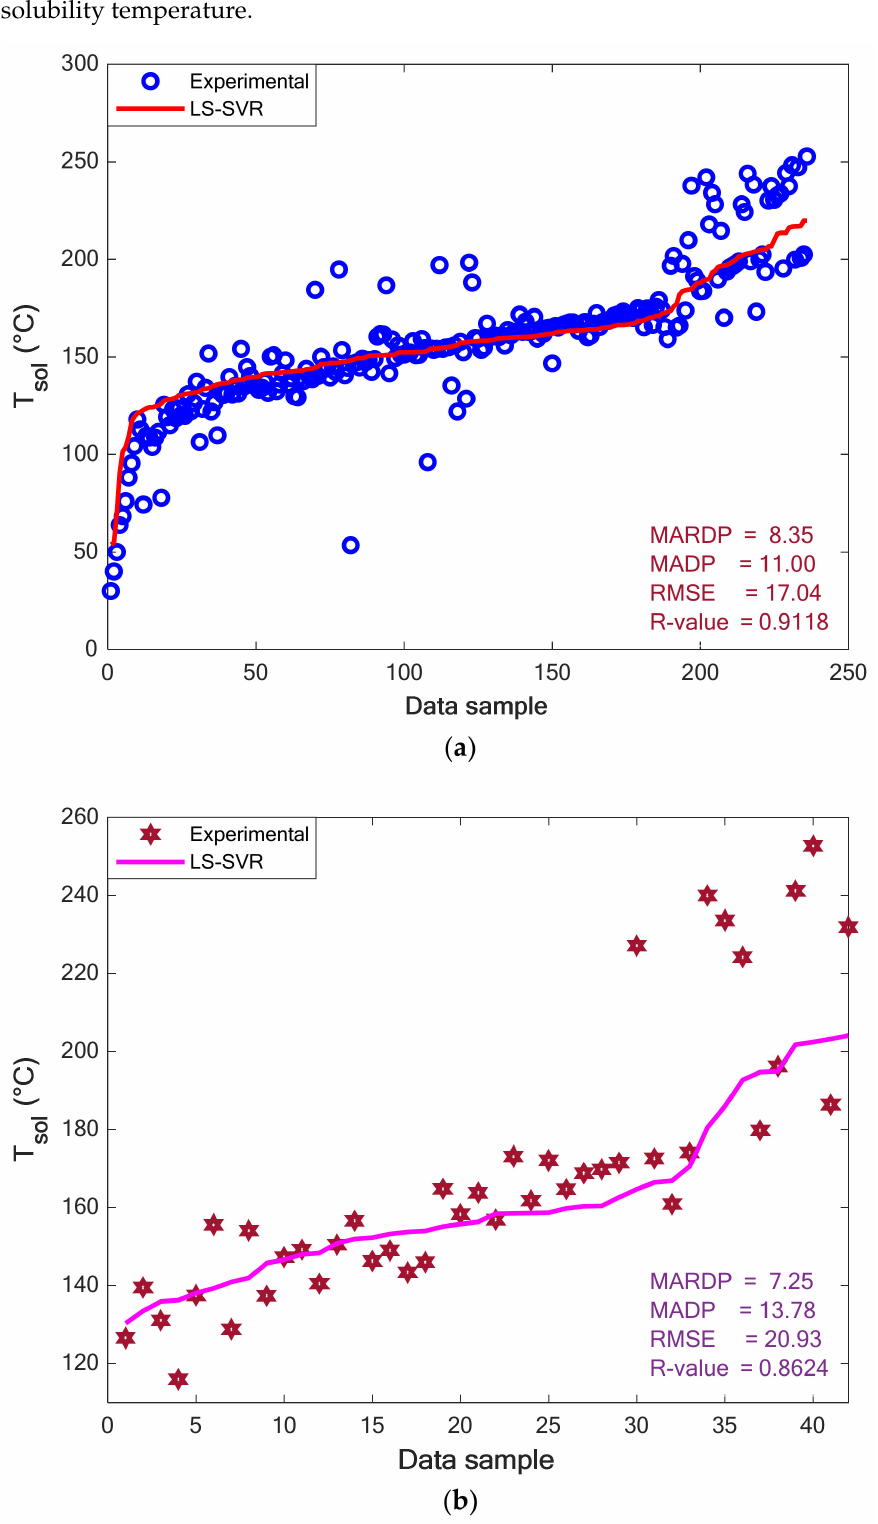
Figure 5. Experimental and modeling values of the solubility temperature in the ( a ) training and ( b ) testing